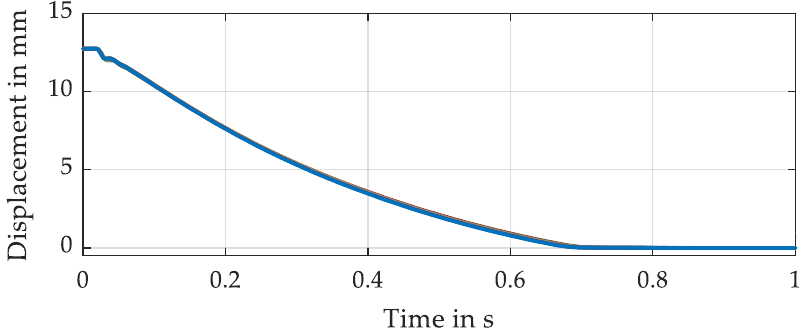
Figure 12. Measured displacement signals for all measurements. Figure 16. Measured displacement signals for all measurements. Figure 16. Measured displacement signals for all measurements.